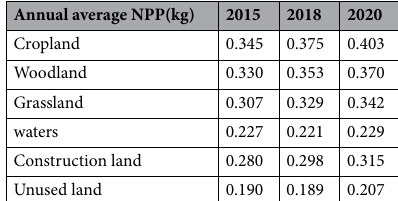
Table 1. Average annual net primary productivity per land type in the Yellow River